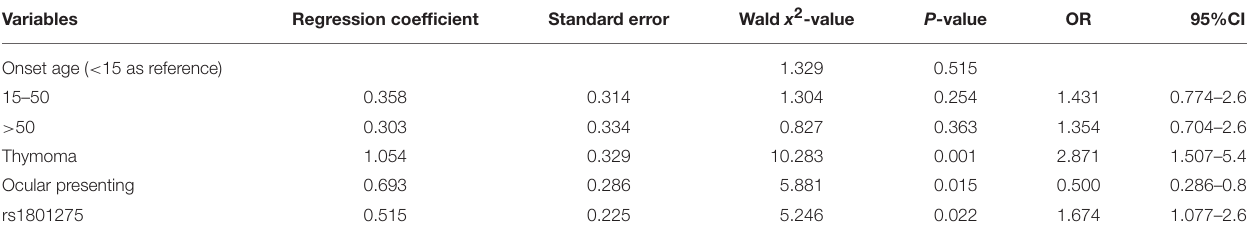
TABLE 5 | Logistic regression analysis in subgroups classified by AChR-Ab.